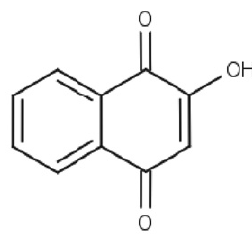
Figure 1. Structure of lawsone